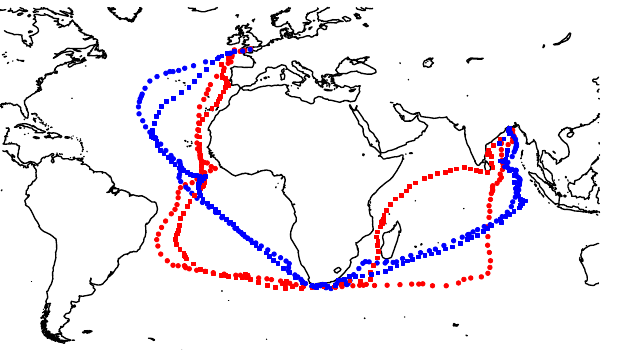
Fig. 3. Daily positions on the outward (red) and return (blue) voy- ages of the Astel in 1812–1813 (squares) and Thomas Grenville in 1827–1828 (circles).